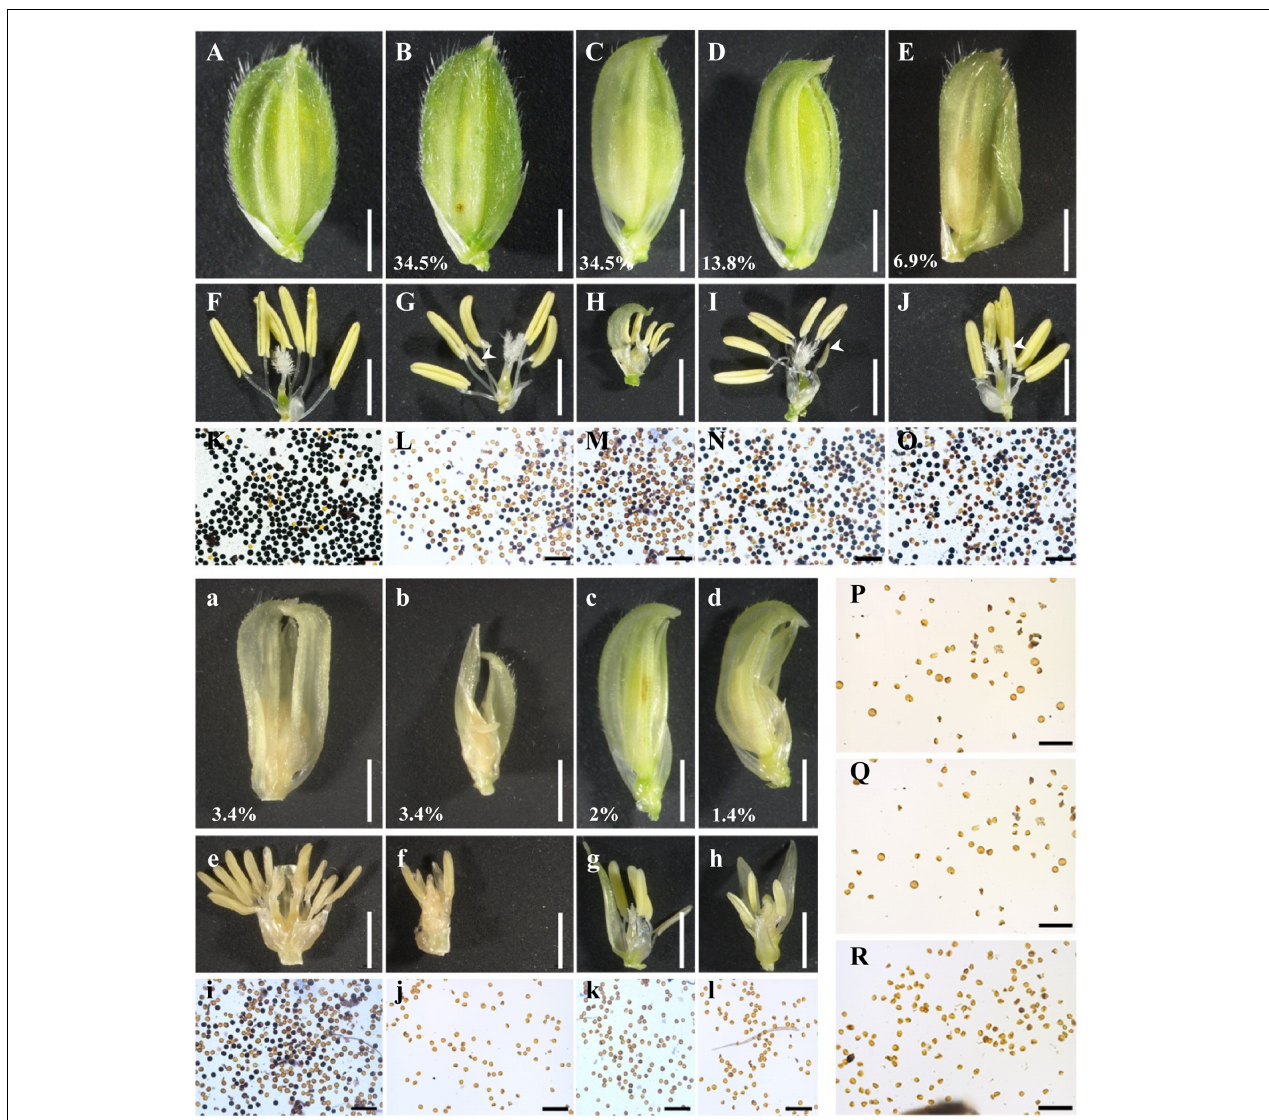
FIGURE 2 | Floret and pollen fertility comparisons of the wild type and osemf2b-4. (A) A wild type spikelet; (B–E) four types of slight floret defects with stamens including small husk (B) , beak-like (C) , open husk (D) , and long sterile lemma (E) spikelets in osemf2b-4 plants, bars = 2 mm; (F–J) spikelets after removing the lemma and palea, bars = 2 mm; (K–R) I 2 -KI pollen staining, (L–O) pollen from yellow anthers, (P–R) pollen from three white anthers (white arrowheads), respectively. Bars = 200 µ m. (a–d) Four types of severe floret defects with stamens such as double lemma (a) , coiled lemma and palea (b) , missing lemma or palea (c) , and leaf-like (d) spikelets in osemf2b-4 mutant, Bars = 2 mm; (e–h) spikelets after removing the lemma and palea, bars = 2 mm; (i–l) Pollen fertility using I 2 -KI pollen staining. Numbers indicate the ratio of different types of floral organ defects with stamens per plant. Bars = 200 µ